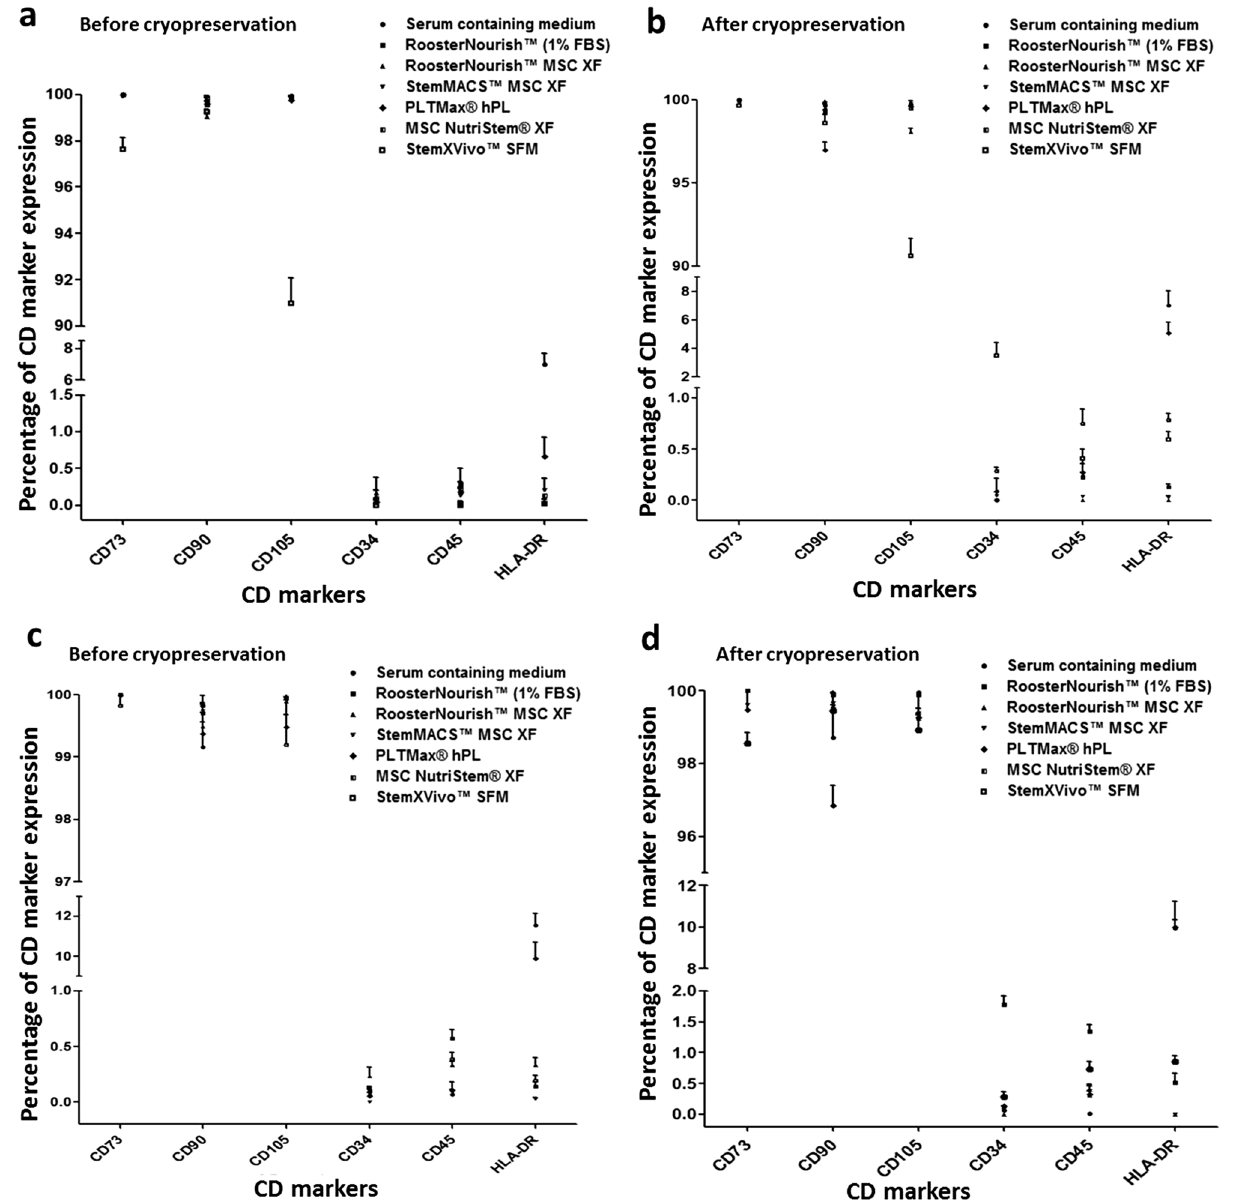
Figure 5. Immunophenotyping of human BM-MSCs cultured in low serum/ SFM/XFM before and after cryopreservation in the two different seeding densities (1000 cells/cm 2 and 5000 cells/cm 2 ). The known positive and negative human MSC specific cell surface antigens were estimated by flow cytometry. Isotope-matched controls were used to determine the non-specific binding by PE and FITC-conjugated antibodies. All the experiments were performed in duplicates and the data is represented as mean ± SD. The expression of positive markers (CD73, CD90 and CD 105) was more than 90% and that of negative markers (CD34, CD45) was less than 5% before and after cryopreservation in the seeding densities of 1000 cells/cm 2 (a & b) and 5000 cells/cm 2 (c & d) . However the expression of HLA-DR of BM-MSCs cultured in control medium and PLTMax hPL were 7.0–11.76% ± 0.66 and 0.67–10% ± 0.76